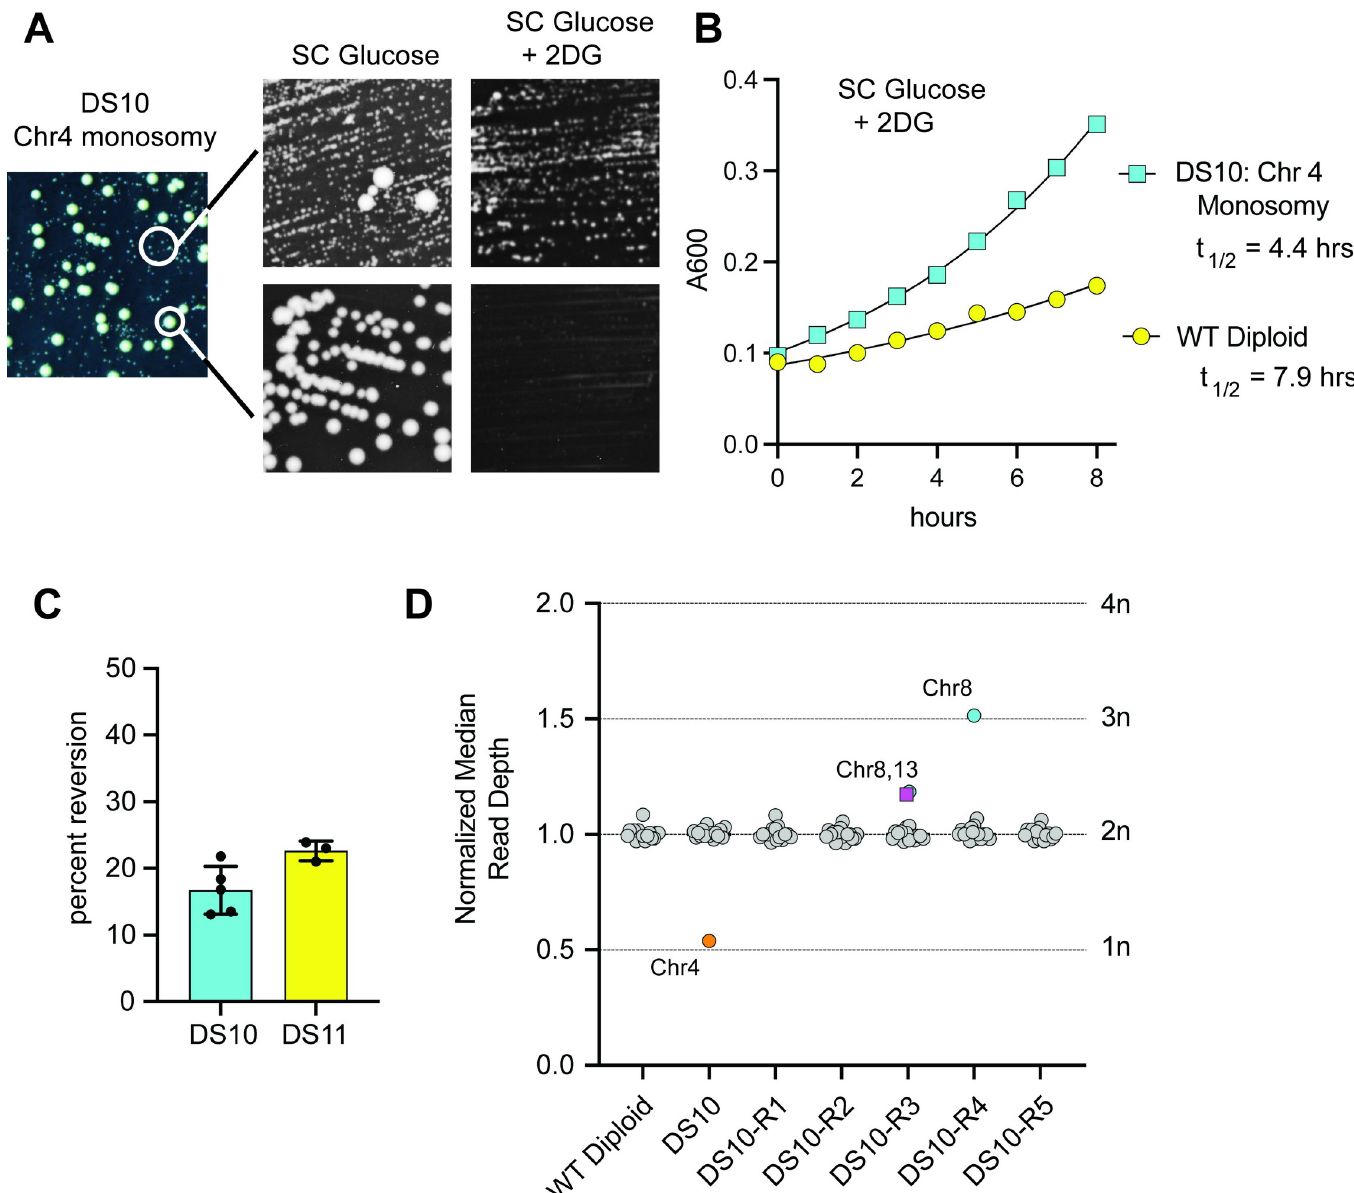
Fig 4. Monosomy of chromosome 4 confers 2DG resistance and reverts at high frequency. A. Growth properties DS10 cells on agar plates. Small and large colonies of DS10 were re-streaked onto agar plates with the media indicated above. B. Growth of DS10 cells and wild type diploid cells in media containing 2DG. C . Reversion of small colony phenotype. Multiple, independent populations of small colonies from strains DS10 and DS11 were spread on plates containing SC medium. The mean percentage ( ± SD) of colonies that reverted to the large colony phenotype for each independent replicate is shown. D. Chromosomal ploidy analysis of DS10 and revertants. Normalized median read depth for each chromosome is plotted for wild type, DS10 and five DS10 revertants (DS10-R). Chromosomes that diverge from normal ploidy (2n) are indicated.